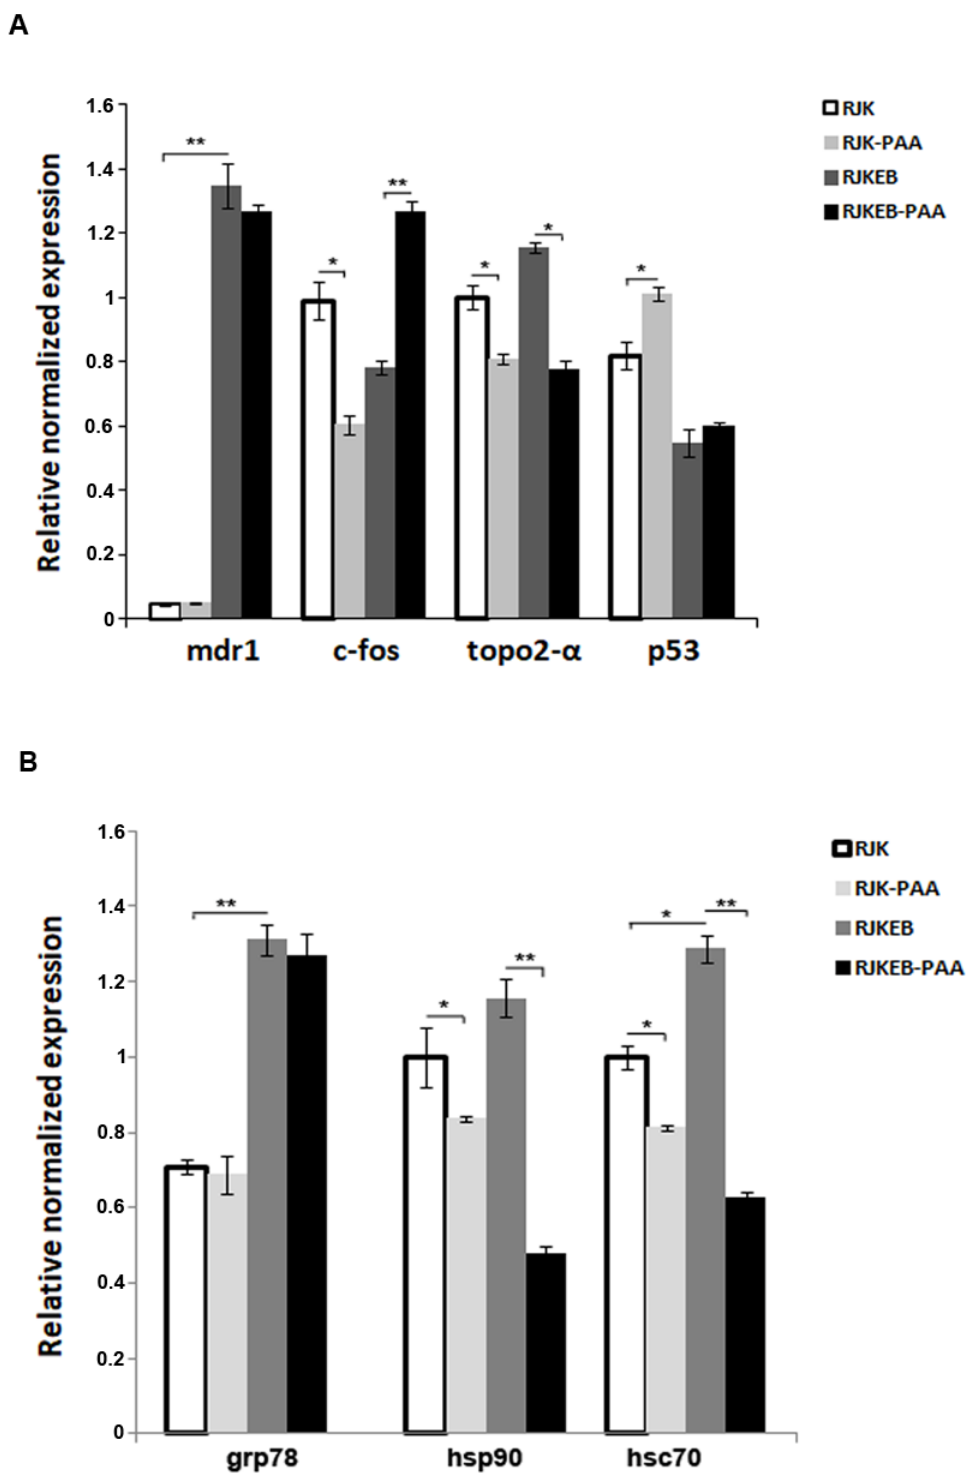
Figure4. GeneexpressiononRJKandRJKEBcellssurvivedafterPAAexposure. ( A )qRT-PCRanalysisof the gene mdr1 , c-fos , topo2- α , p53 level in RJK, RJK-PAA, RJKEB, RJKEB-PAA cells. ( B ) qRT-PCR analysis of the gene grp78 , hsp90 , hsc70 level in RJK, RJK-PAA, RJKEB, RJKEB-PAA cells. The mean ± SD of three independent experiments are presented (* p < 0.05; ** p < 0.01). Abbreviations: RJK—Chinese hamster cells CHLV-79 RJK; RJKEB—RJK resistant to ethidium bromide; PAA—polyallylamine hydrochloride; RJK-PAA—RJK cells after PAA treatment; RJKEB-PAA—RJKEB cells after PAA treatment; EB—ethidium bromide; qRT-PCR—quantitative reverse transcription polymerase chain